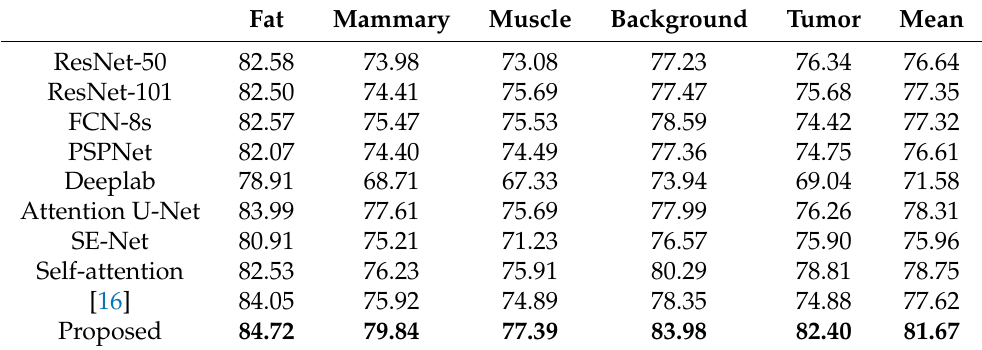
Table 3. Results of Multi-object Semantic Segmentation. Evaluation Metric is IoU (%).